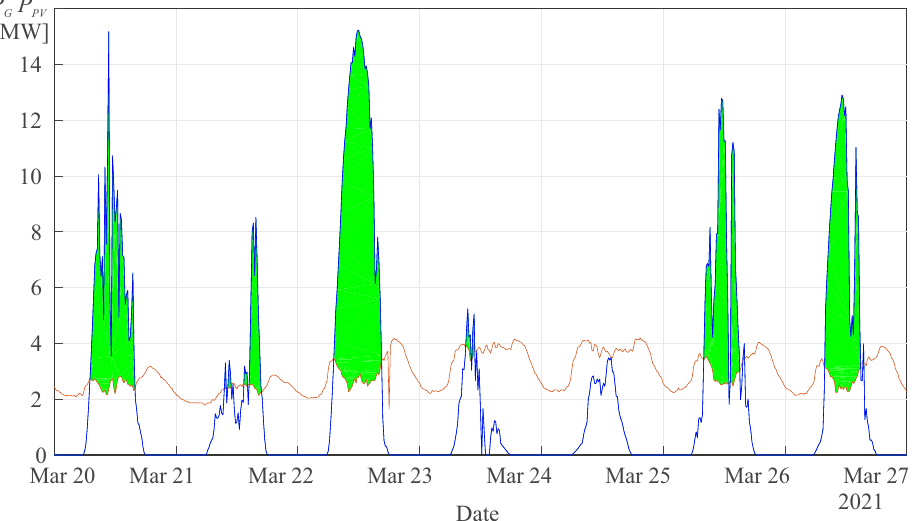
Figure 1. Sample measurement result in 110/15 kV substations; red: energy consumption from the transformer; blue: potential PV power generation, including sources to be connected in the future; the wave forms of PV generation were determined on the basis of measurements from a 1 MWp power plant; green field: energy that must be sent to the power grid to other loads or stored in the